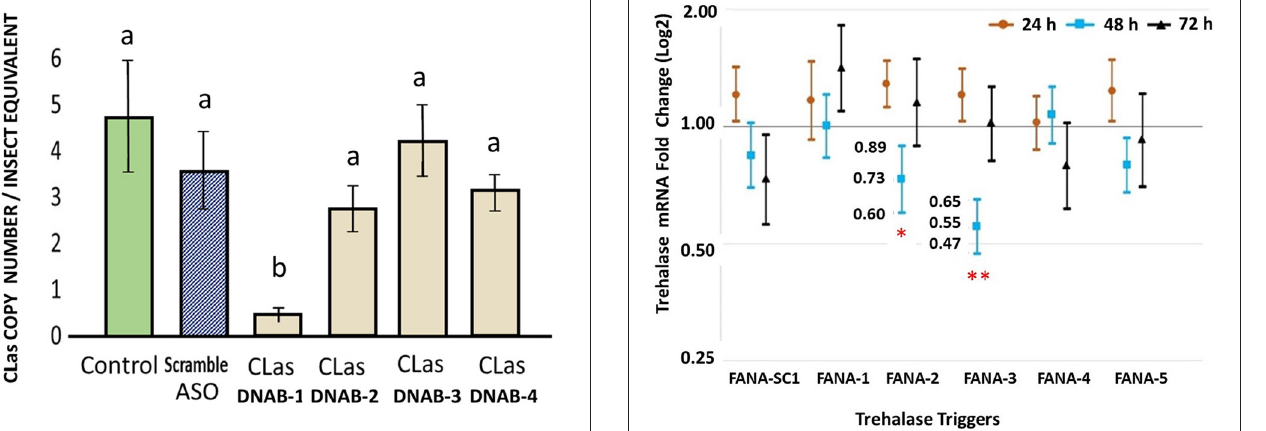
FIGURE 7 | Feeding bioassay on diet targeting trehalase-of psyllid, D. citri. The qPCR analysis revealed that the treatments with FANA DcTRS-2 and DcTRS-3 significantly reduced mRNA Trehalase in the psyllids, D. citri at 48 h-post feeding (with reductions of 0.73 log fold and 0.55 log fold less total mRNA, respectively). Comparison of means post-hoc test using Tukey ( P < 0.05). Error bars represent ± SE of the mean from six biological replicates, from three experimental